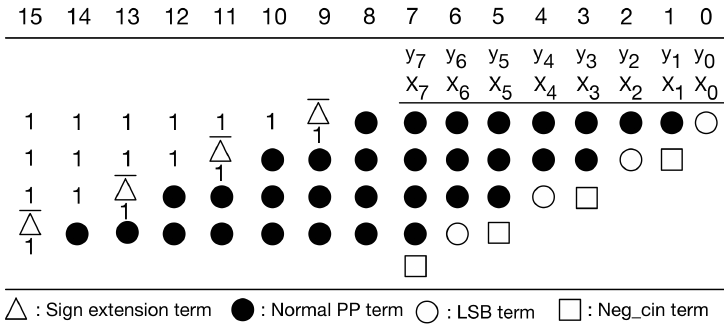
Figure 8. Replace sign extension terms.